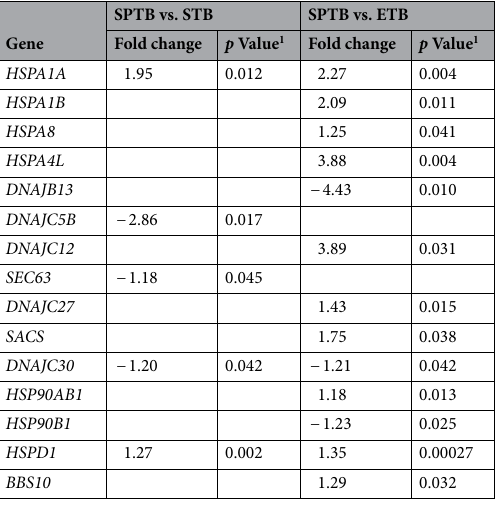
Table 2. Significant ( p < 0.05) differences in HSP gene regulation among SPTB, STB, and ETB in placental transcriptomics data. 1 Nominal association.